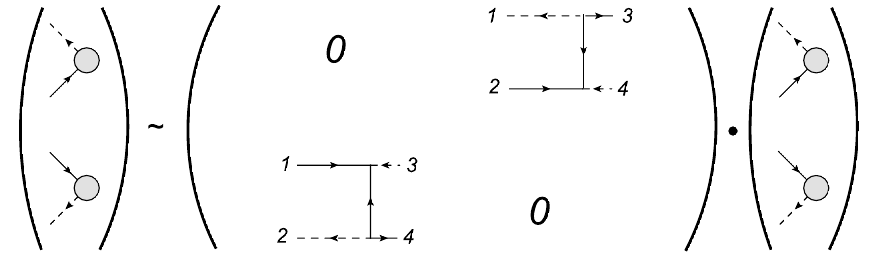
, K (2) . In the figure the real lines represent fermionic d d